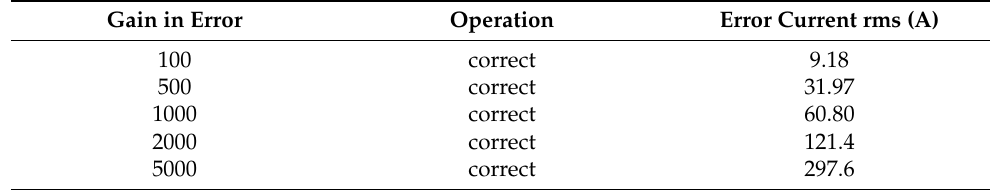
Table 4. Information of A/D error of MU in real IED for protection ANSI 51.